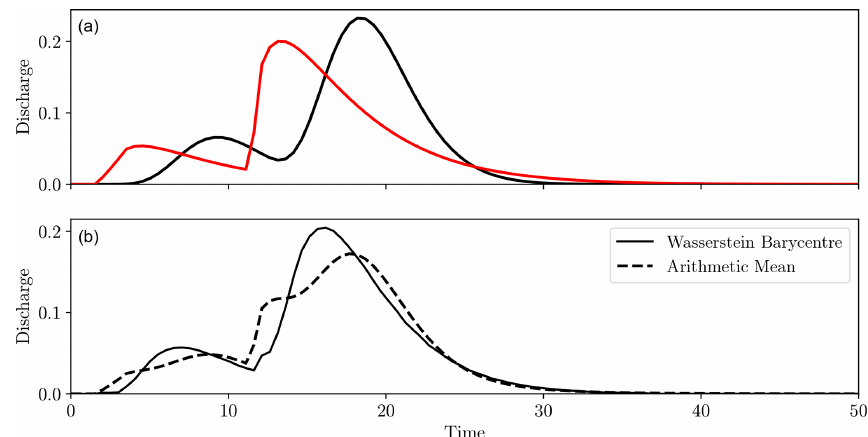
Figure 18. Two hydrographs for the same rainfall event but with different hydrological models ( a , black and red solid lines). Panel (b) shows the Wasserstein barycentre in solid black and the mean in dashed